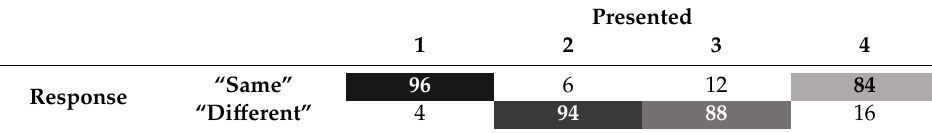
Table 4. The result of the second